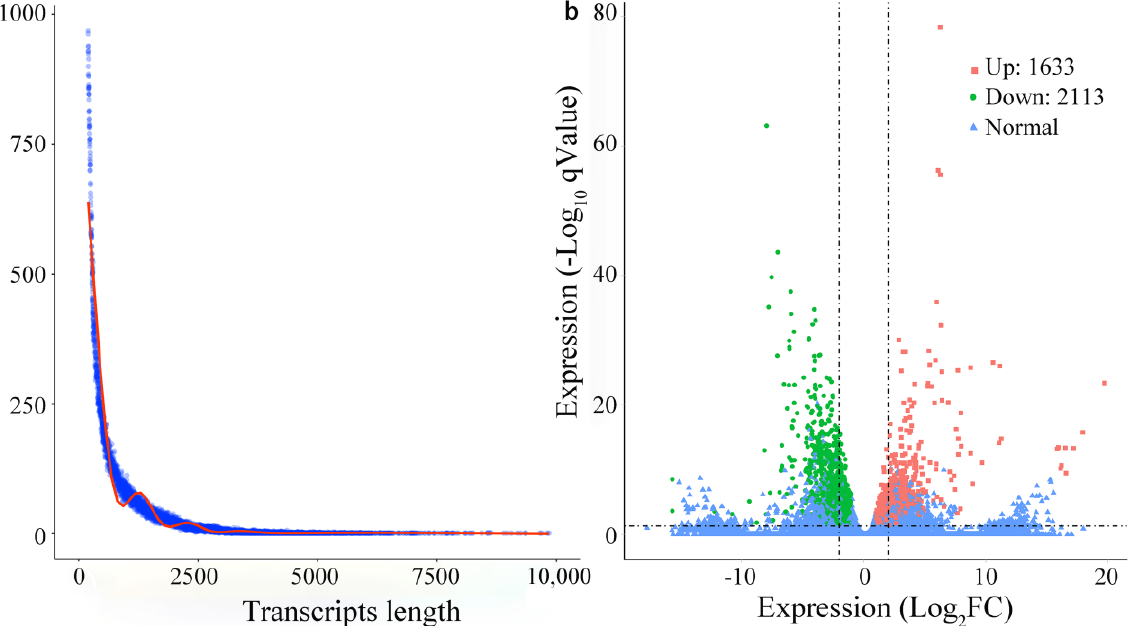
fold changes and FDR values of the DEGs.